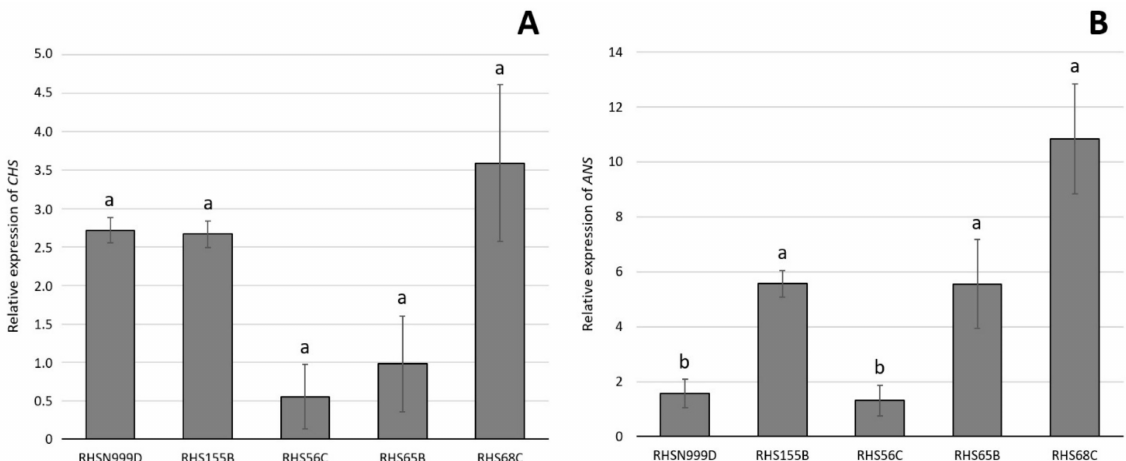
Figure 2. Relative expression of chalcone synthase ( CHS ) ( A ) and anthocyanidin synthase ( ANS ) ( B ) evaluated by real-time quantitative polymerase chain reaction (qPCR) in tepals of 5 Alstroemeria pallida accessions ( ± standard error (SE), n = 12). Results are shown as expression relative to the housekeeping gene eEF1A . Different letters indicate significant differences using ANOVA followed by an LSD test ( p ≤